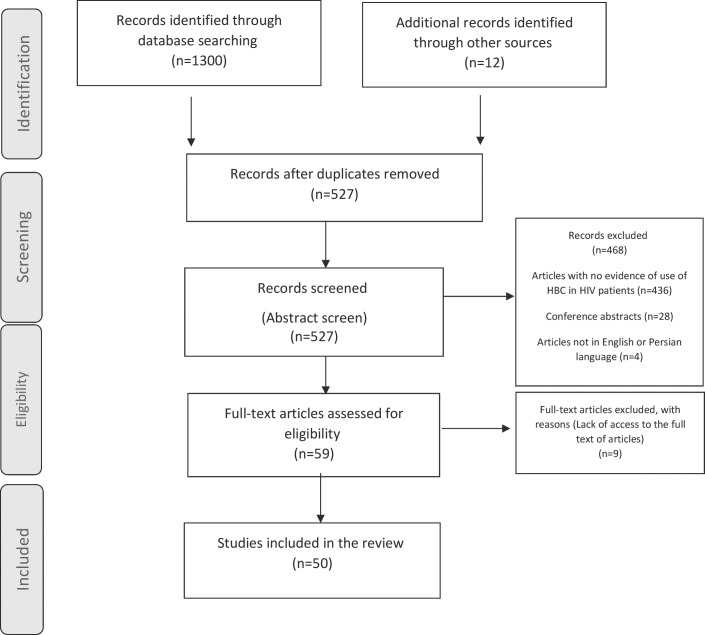
 PRISMA ﬂow diagram